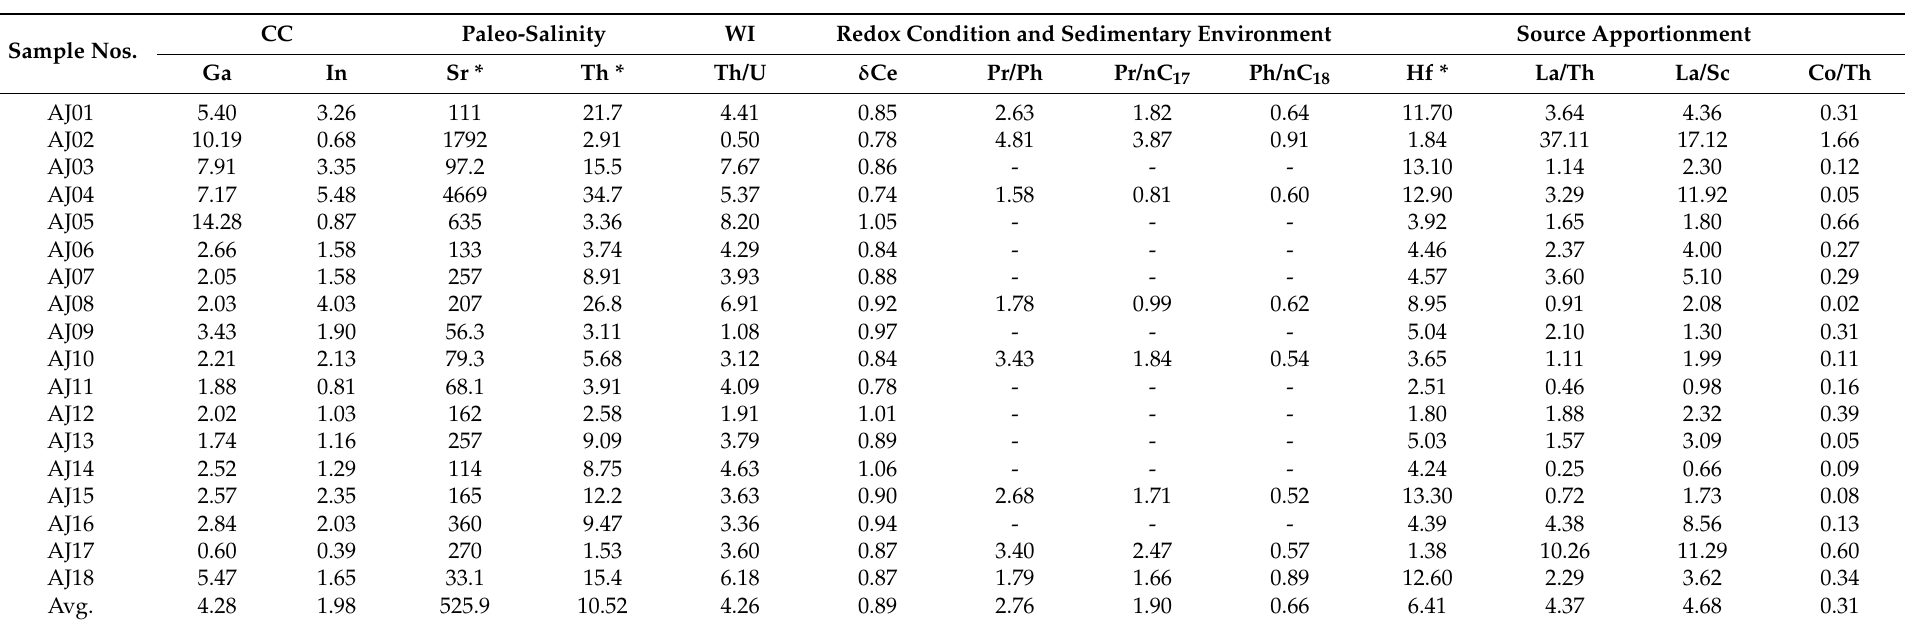
Table 2. Parameters for enrichment classification, identification of deposition condition and source apportionment of Ga and In in No. 9 coals. Sample